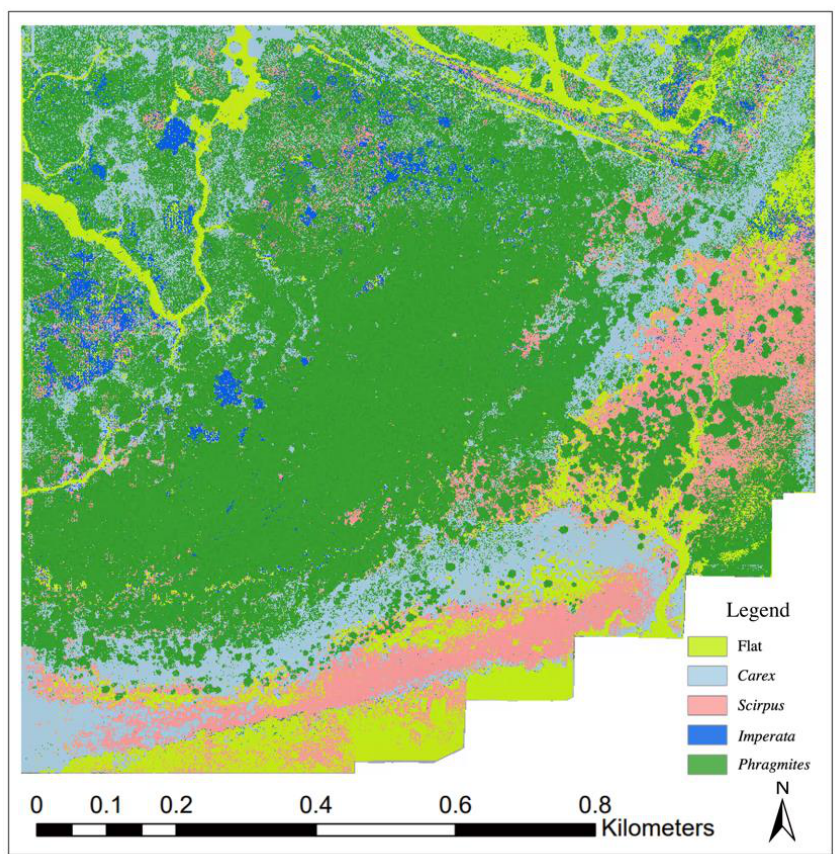
Figure A1. Thematic map of PB classification in the study area, in which all features (RGB + VI + Texture + DSM) are used.